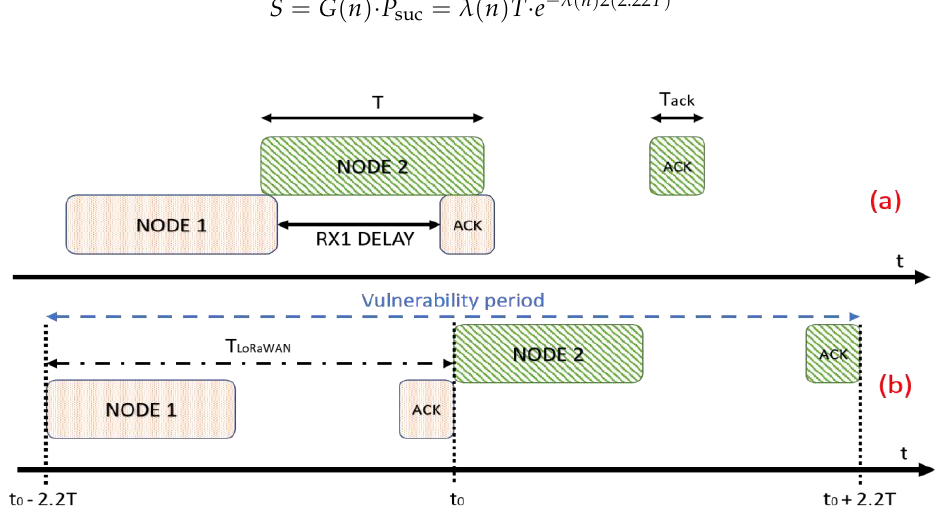
Figure 4. Vulnerability period in LoRaWAN with ACK. ( a ) T is greater than RX1 Delay, a collision must occur; ( b ) vulnerability period needed to perform a successful link between an end device and the gateway.